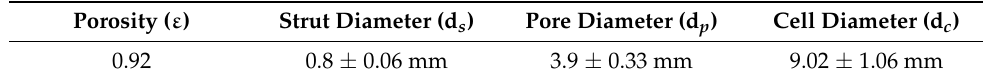
Table 1. Geometrical characteristics of utilized foam.